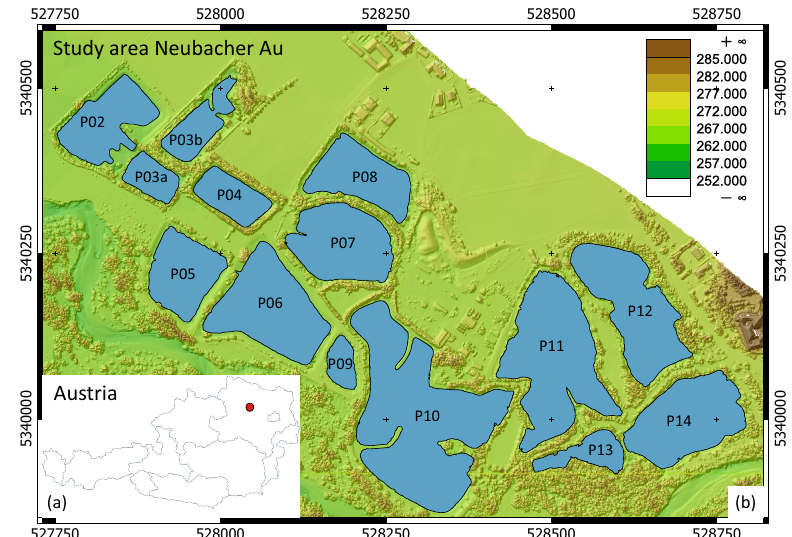
Figure 5. Topo-Bathymetric LiDAR area Neubacher Au, Pielach River, Austria; ( a ) overview map of Austria, red circle: location of the study area; ( b ) Digital Surface Model of Neubacher Au flood plain with groundwater supplied ponds (blue polygons), combination of shaded relief and color-coded height map, coordinate reference frame: ETRS89/UTM 33N, ellipsoid heights, units =